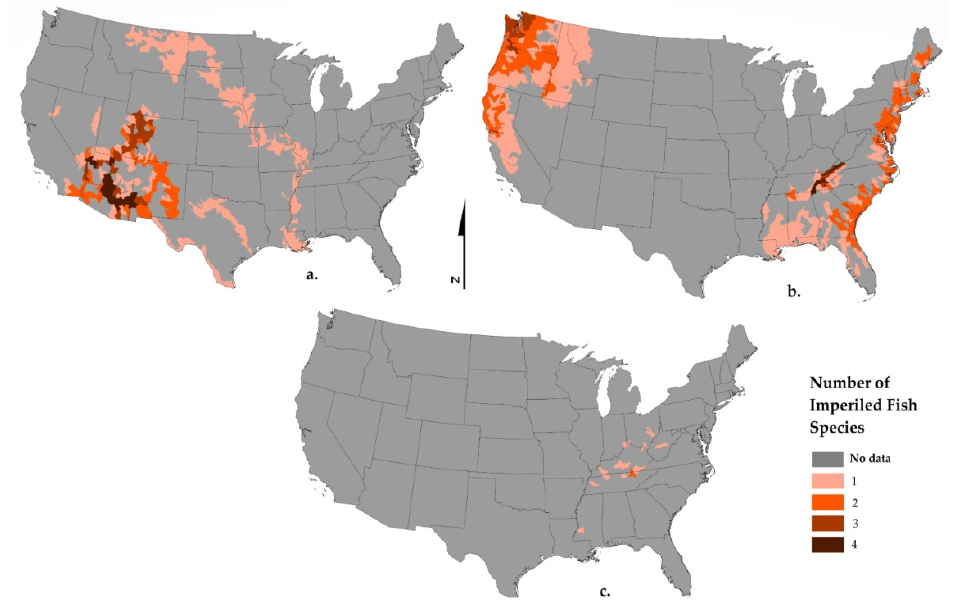
Figure 5. ( a ) Imperiled fishes associated with low-forested areas (number of endangered freshwater fishes in each HUC8 that have more than one quarter of their distribution is in watersheds with 26–50% forested area). ( b ) Imperiled fishes associated with forested areas (number of endangered freshwater fishes in each HUC8 that have more than half of their distribution in watersheds with 51–75% forested area). ( c ) Imperiled fishes strictly associated with highly forested conditions (number of endangered freshwater fishes in HUC8s that have more than three quarters of their distribution in HUC8s with 76–100% forested area). This dataset only includes HUC8s where endangered fish are recorded, and HUC8s without imperiled fish are recorded as “no data”. Table 5. Species list of imperiled fishes in three different forested conditions. Seventeen fish species have more than 25% of their distribution in low-forested areas (26–50% forested); ten fish species have more than 50% of their distribution in moderately forested areas (51–75%); and four fish species have more than 75% of their distribution in highly forested areas